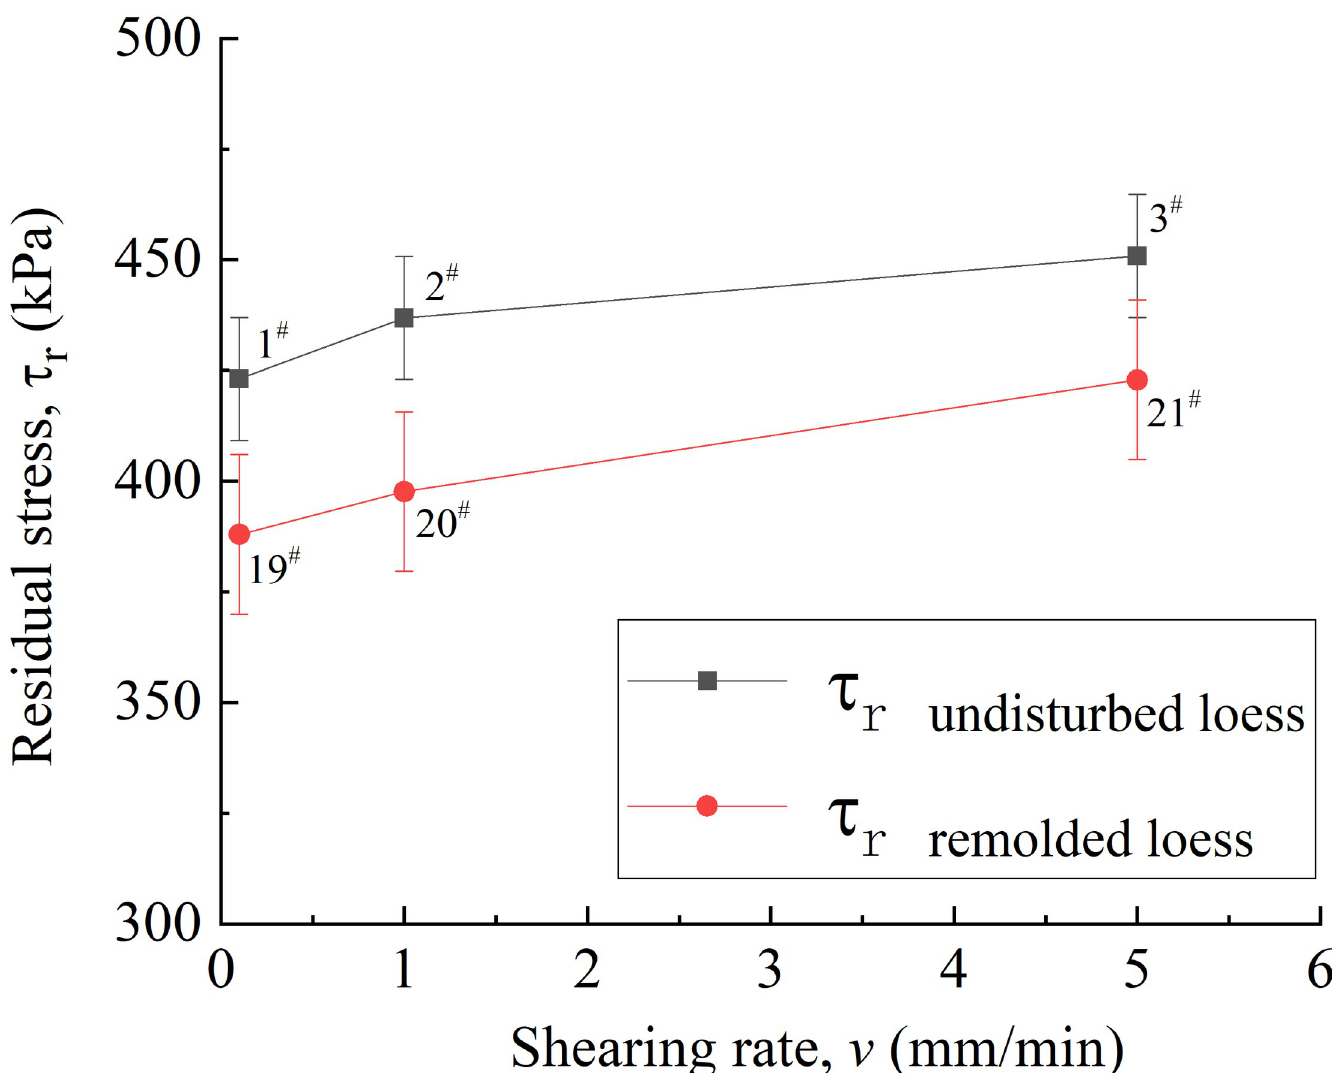
Fig 8. Residual strain-shearing rate curve of 1 # - 3 # undisturbed and 19 # - 21 # remolded loess specimens.